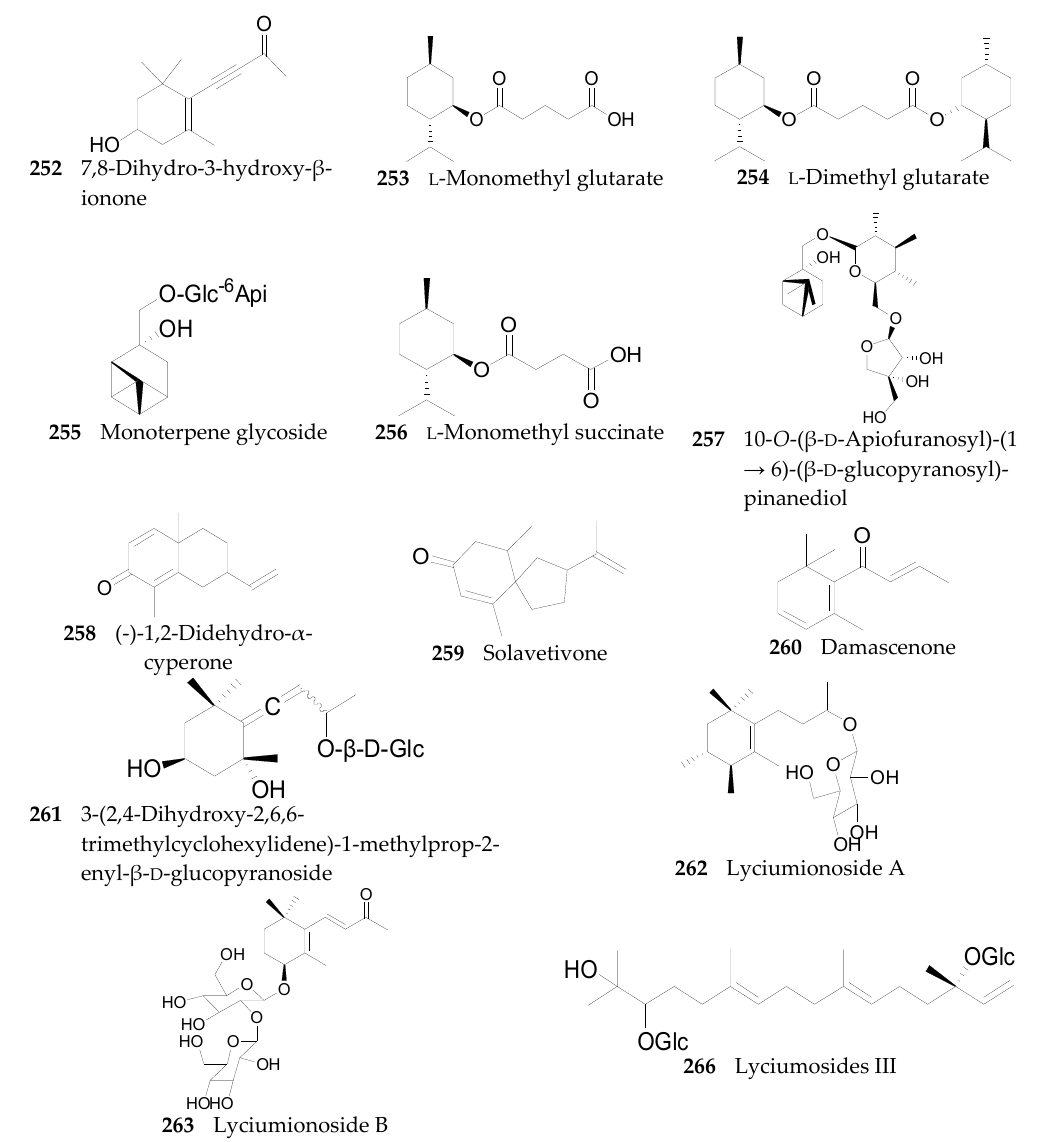
Figure 19. Chemical structures of compounds 252 – 263 , 266 . Table 11. Chemical structures of compounds 264 – 265 , 267 – 270 and 272 – 273 .